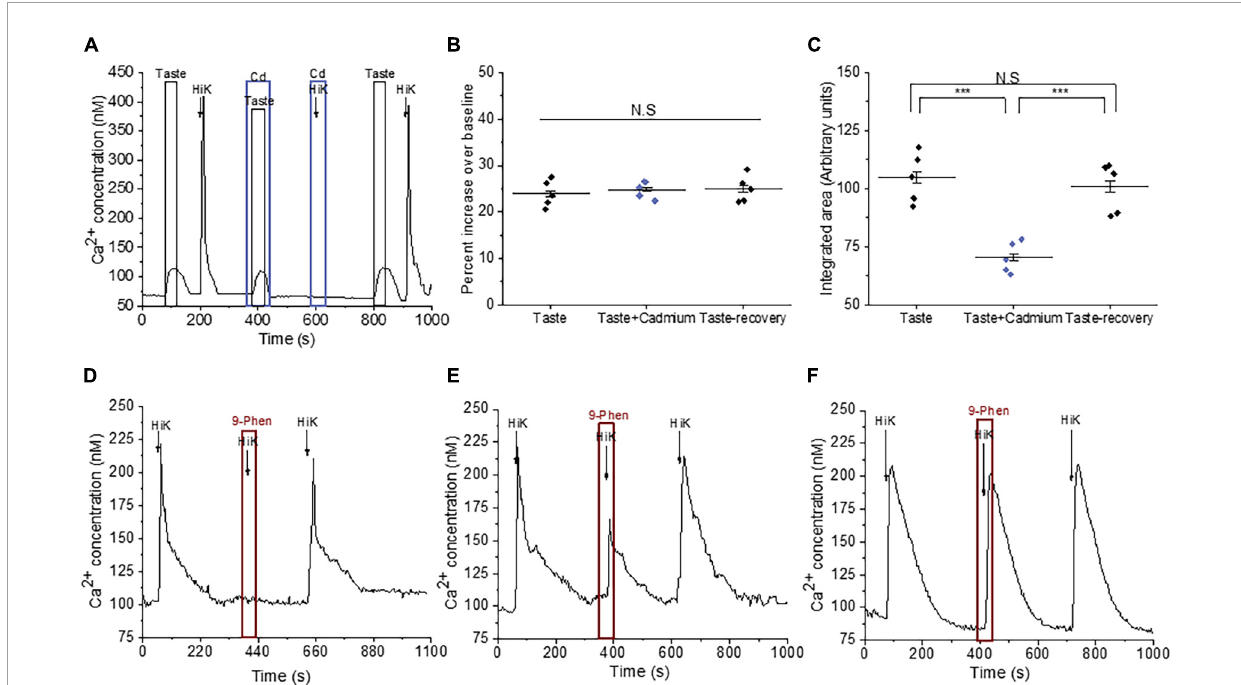
FIGURE2 TRPM4 modulates the activity of VGCCs in Type III taste cells. (A) A representative calcium imaging trace showing cadmium (200 µ M) reduced the taste-evoked calcium responses and abolished the calcium influx signals generated by 50 mM KCl. (B,C) Cadmium, a general VGCC blocker, did not affect the amplitudes of the taste-evoked calcium responses ( F ( 2 , 12 ) = 0.23; p = 0.79) but significantly reduced the magnitudes (integrated area) ( F ( 2 , 12 ) = 18.99, p = 0.00019, n = 5 cells from 5 mice). (D) Inhibition of TRPM4 abolished the calcium influx signals in some Type III cells ( n = 15 cells from 3 mice), while 9-phenanthrol partially inhibited calcium influx in other cells ( E ; n = 9 cells from 3 mice). (F) In other Type III cells, TRPM4 inhibition did not affect the calcium influx signals ( n = 24 cells from 7 mice) (*** P < 0.001; N.S =